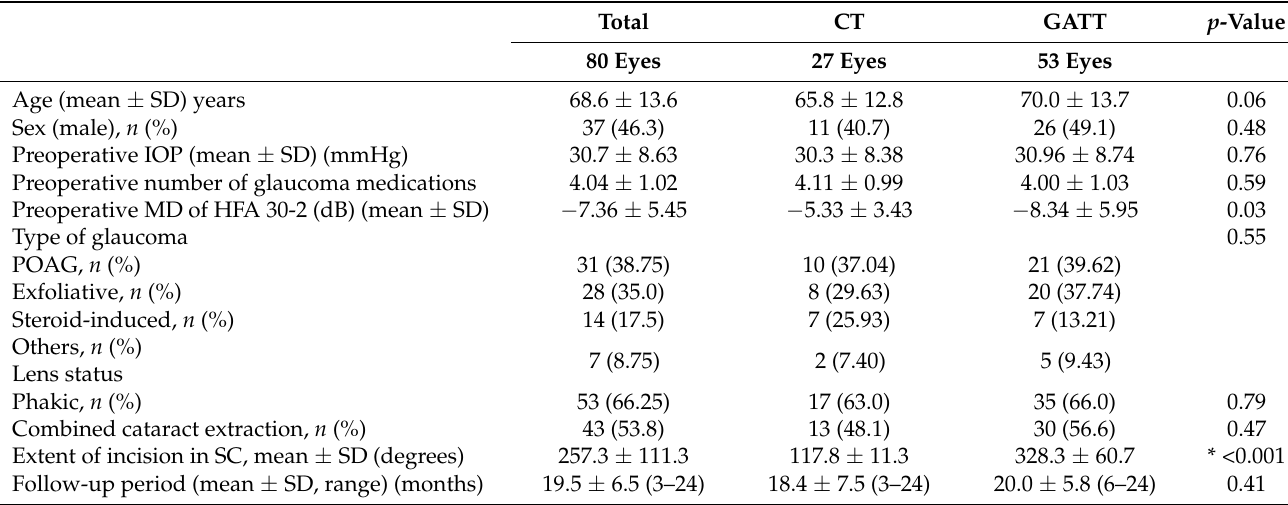
Table 1. Patients’